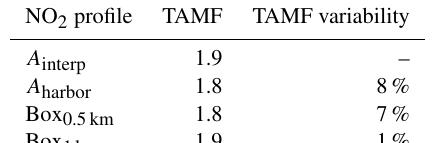
Table 6. A priori NO 2 profile shape sensitivity study with four sce- narios: integration along (1) local NO 2 vertical profiles A interp , in- terpolated on the AURORA model grid; (2) a fixed AURORA NO 2 profile A harbor over a polluted area; (3) a well-mixed NO 2 box pro- file of 0.5km and (4) 1km height in the lowest layer. TAMFs for the Antwerp data set are calculated based on the four scenarios, as well as the variability between the first scenario and the other three.